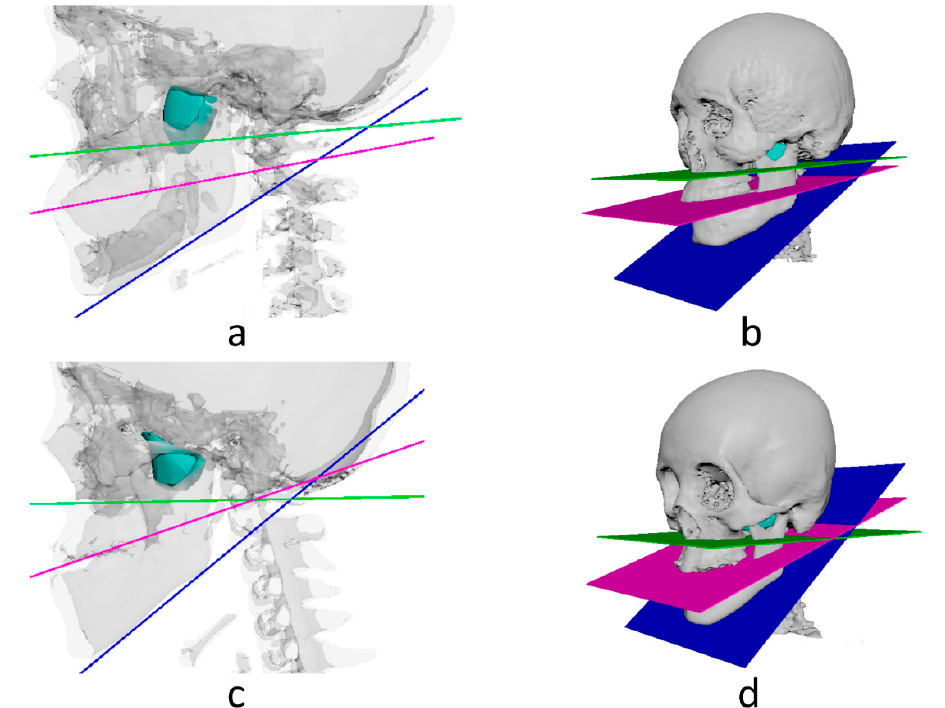
Figure 2. The values between the lateral pterygoid muscle and 3 reference planes were calculated three-dimensionally using surface planes. The surface planes of the palatal (green), occlusal (violet), and mandibular planes (blue) were organized based on cranial shape. Lateral pterygoid and 3 reference planes for ( a ) sagittal view and ( b ) directional view of the normal group and ( c ) sagittal view and ( d ) directional view of the prognathic group (Maya, version 2022, autodesk.com, accessed on 28 Aug 2021).